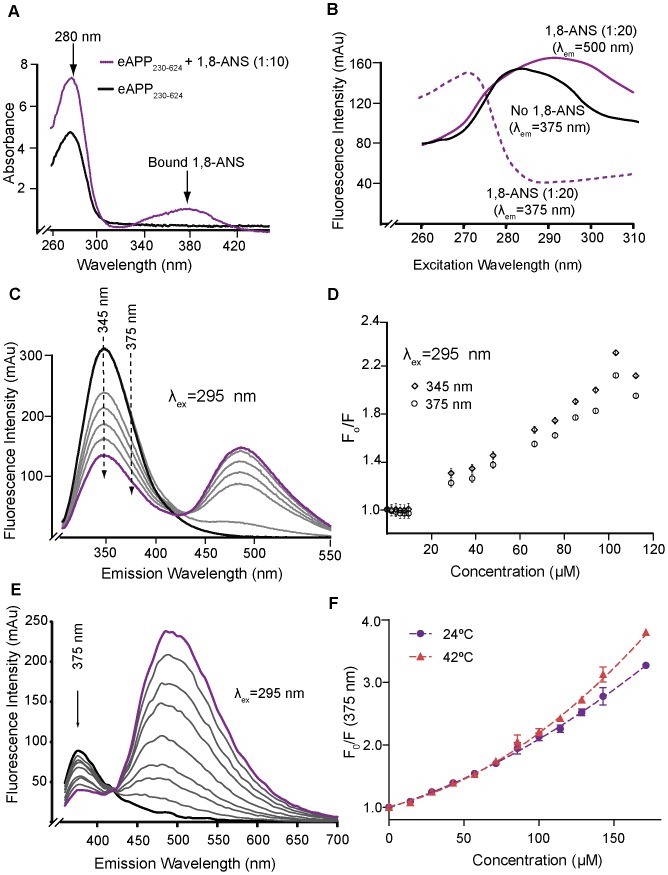
1,8-ANS binds to eAPP230–624.A) Difference absorption spectra of eAPP230–624 in the presence of 1,8-ANS (purple) at a 1∶10 molar ratio. For each difference curve, the absorption spectra of PBS, PBS plus 1,8-ANS was subtracted from the absorption spectra of 3 µM eAPP230–624 in the same buffer. The appearance of significant changes in the peak absorption near 280 is consistent with perturbations in the environment of some of the aromatic residues in eAPP230–624 caused by the binding of 1,8-ANS. The broad absorption peak centered on 380 nm is characteristic of 1,8-ANS bound to protein [55]. B) Comparison of the excitation peak for the intrinsic fluorescence at 375 nm for 3 µM eAPP230–624 alone (solid black) and in the presence of 1,8-ANS at molar ratio of 1∶20 protein to 1,8-ANS at 375 nm (dotted purple) and 500 nm (purple). This comparison shows that the presence of 1,8-ANS at a 1∶20 molar ratio is sufficient to redirect the absorbed photons in the region dominated by tryptophan absorption (285–300 nm) into emission peak of 1,8-ANS at 500 nm consistent with FRET between the tryptophans and bound 1,8-ANS molecules. C) Emission spectra of the titration of 0.64 µM eAPP230–624 with 1,8-ANS from 0–120 µM (1∶0–1∶180 molar ratio) using the Shimadzu RF-530PC. The black line indicates the starting concentration and the purple line indicates the final concentration. D) Stern-Volmer plot for intermolecular quenching of the intrinsic fluorescence of eAPP230–624 by 1,8-ANS at 24°C derived from titration data from the Shimadzu RF-530PC. E) Emission spectrum of 4 µM eAPP230–624 in PBS with varying molar ratios of 1,8-ANS from 1∶0 (black) to 1∶55 (purple) obtained using the Spectramax XPS. F) Stern-Volmer plot for intermolecular quenching of the intrinsic fluorescence of eAPP230–624 by 1,8-ANS at 24°C (purple) and 42°C (red) as measured on the Spectramax XPS. The protein concentration was 2 µM for E–F.